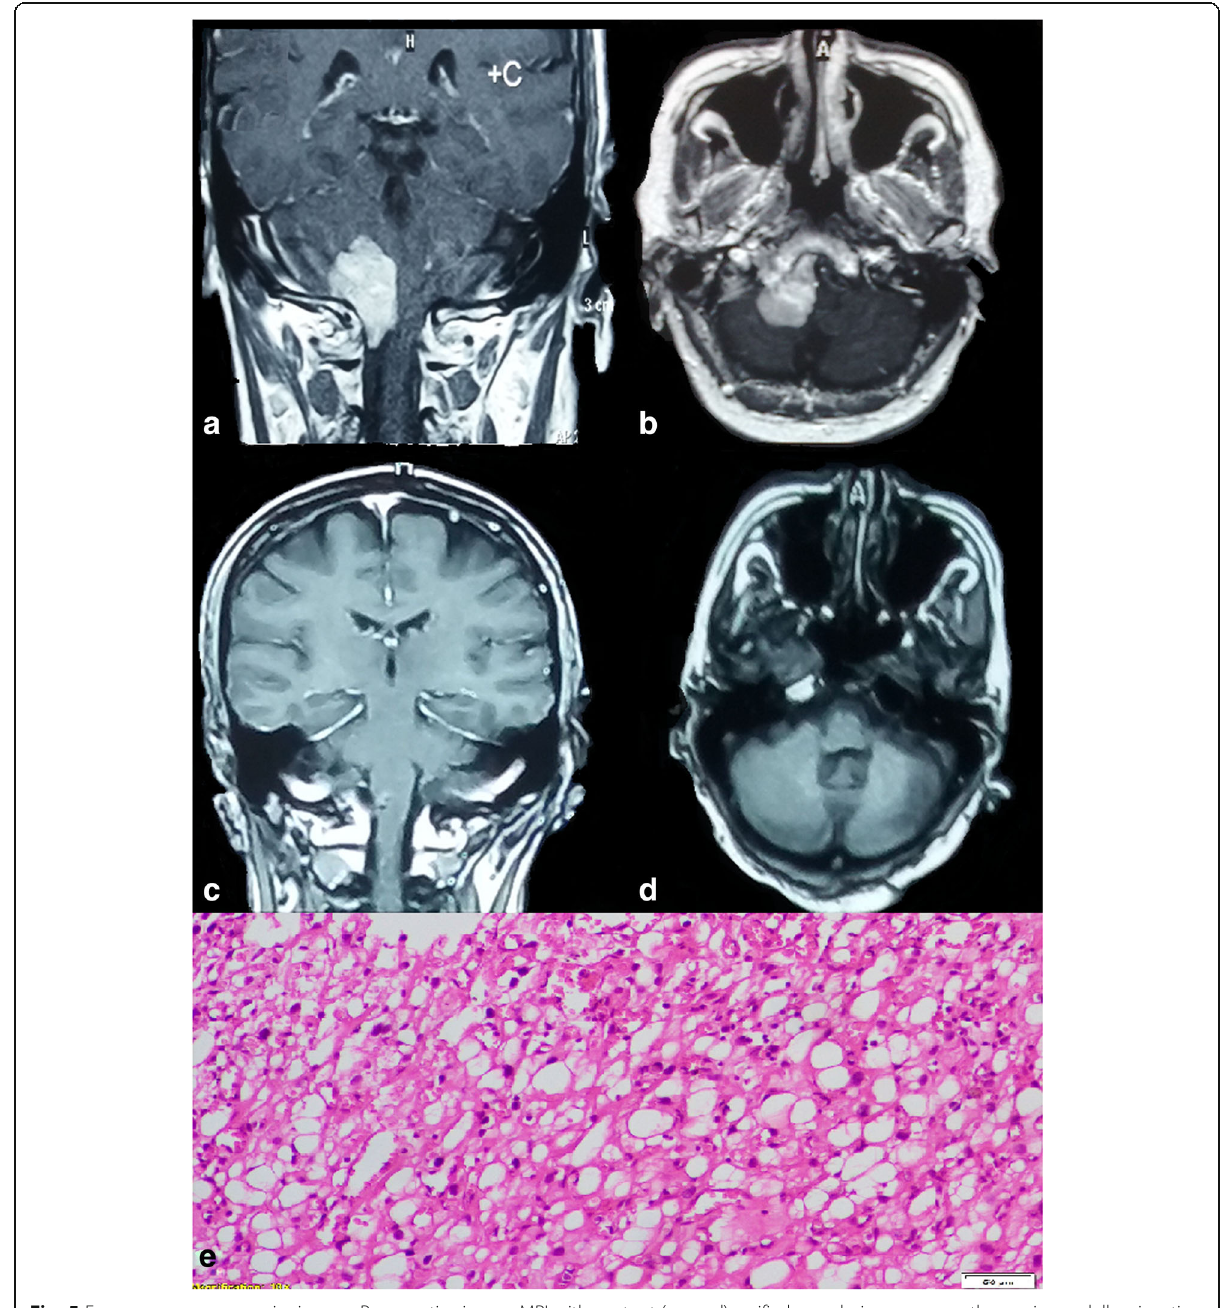
Fig. 5 Foramen magnum meningioma. a Preoperative image, MRI with contrast (coronal) verified mass lesion compress the cervicomedullary junction and upper cervical cord. b MRI with contrast (axial) represented a ventral foramen magnum mass. c One year postoperative MRI with contrast (coronal) showed complete removal of the mass. d The same year MRI with contrast axial view demonstrated small ventral residual with complete medullary decompression. Geriatric Scoring System (GSS) score=18. e The slide revealed a secretory variant of meningioma, WHO grade